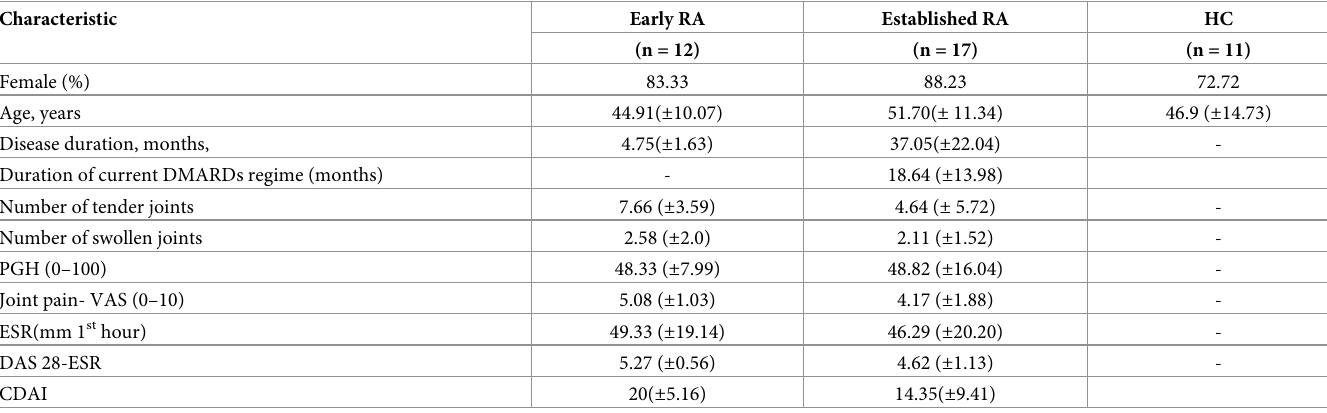
Mean are shown with standard deviation (within brackets) unless specified. Disease-modifying antirheumatic drugs (DMARD); PGH–patient global health; VAS–visual analog scale; ESR–erythrocyte sedimentation rate; CDAI-clinical disease activity index, RA-rheumatoid arthritis, HC-healthy